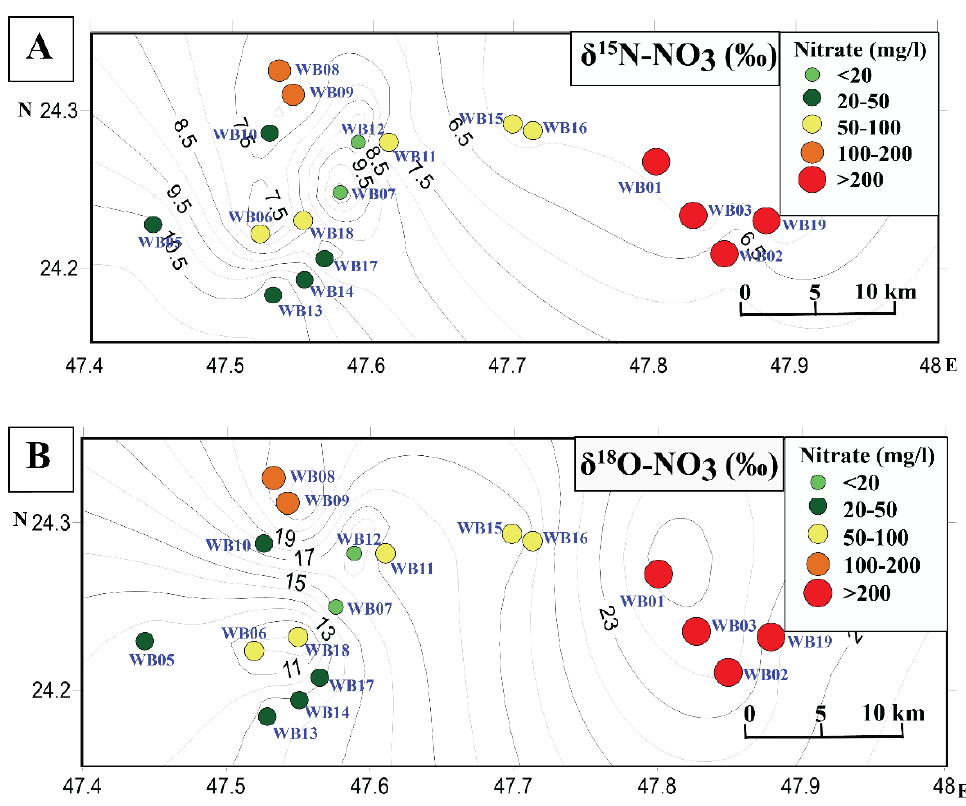
Figure 9. Spatial distribution of ( a ) δ 15 N and ( b ) δ 18 O of nitrate from Wasia groundwater wells in the Al Kharj area. the Al Kharj